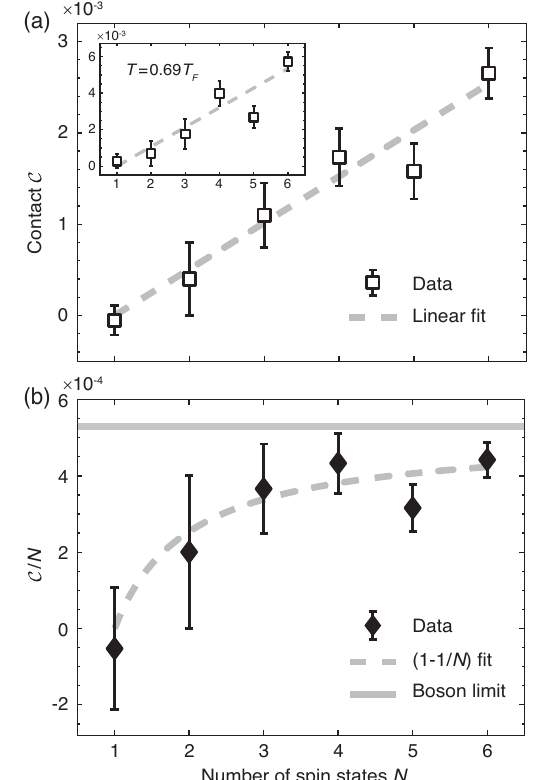
FIG. 4. Bosonization in 3D SU ð N Þ fermions. Scaling of the contact in SU ð N Þ fermions with tunable spin is shown. (a) Con- tacts scale linearly with the number of spin components in a SU ð N Þ Fermi gas. Mean values of collapsed contacts at T ¼ T F of SU ð N Þ gases are plotted as a function of the number of spin states. The dashed line is a linear fit to ( N − 1 ). The inset shows contacts at T ¼ 0 . 69 T F . (b) Contact per spin, C =N , as a function of N . The dashed line indicates a ( 1 − 1 =N ) fit to the data. The horizontal solid line denotes the theoretical result of trapped bosons, N 0 C B = ð 8 π 3 k F N 2 t Þ , multiplied by